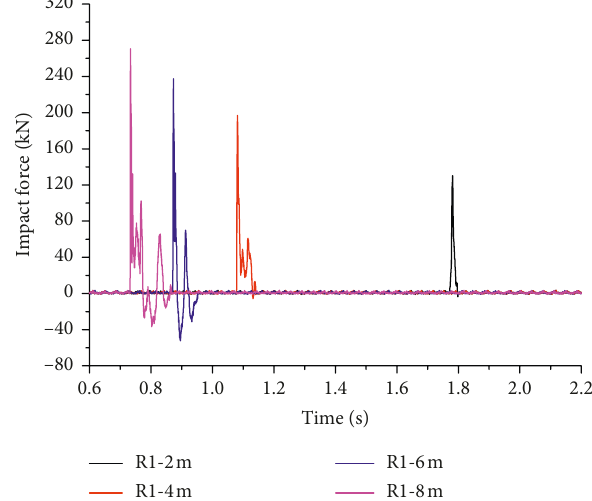
Figure 4: Impact force history of the R1.